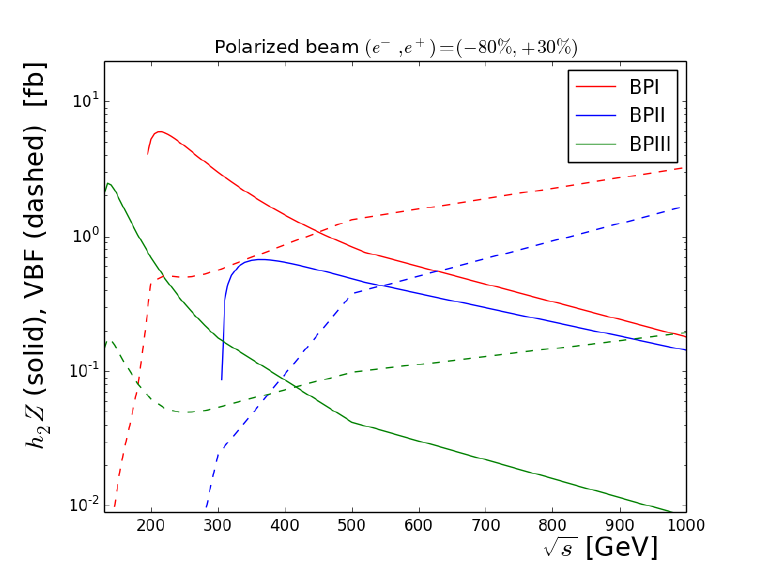
p s in GeV with polarized beams. The